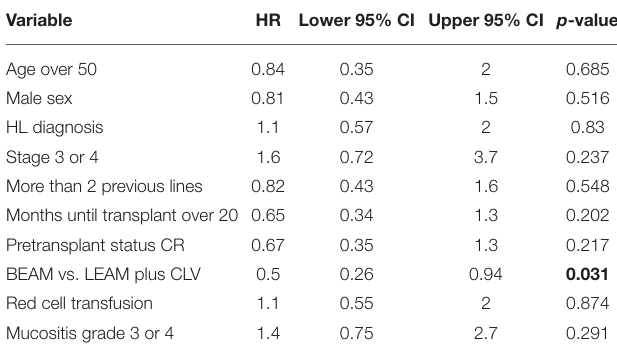
The bold values represent statistically significant values.